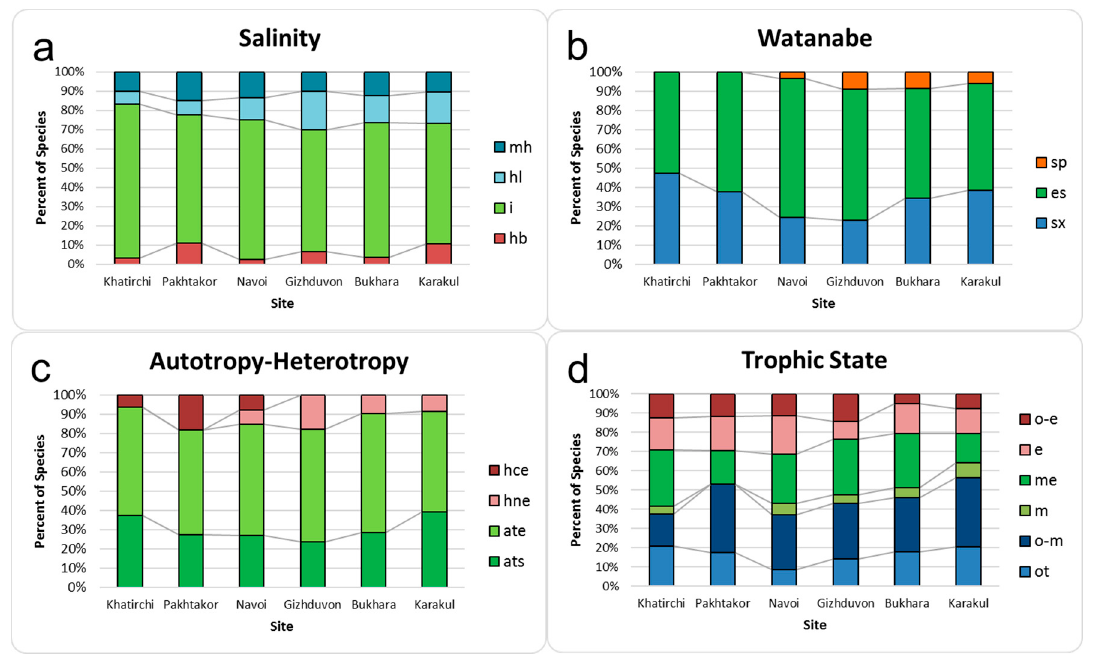
Figure 5. Distribution of bioindicators of salinity preferences, organic pollution according to Watanabe, nutrition type, and trophic state in the Zarafshan River, 2009–2015. Abbreviation for indicator groups: ( a ), Water salinity (Sal): hb, halophobe; i, oligohalobious-indifferent; hl, oligohalobious-halophilous; mh, mesohalobious. ( b ), Organic pollution, Watanabe (D): sx, saproxenes, es, eurysaprobes; sp, saprophiles. ( c ), Nutrition type as Nitrogen uptake metabolism (Aut-Het): ats, nitrogen-autotrophic taxa, tolerating very small concentrations of organically bound nitrogen; ate, nitrogen-autotrophic taxa, tolerating elevated concentrations of organically bound nitrogen; hne, facultatively nitrogen-heterotrophic taxa, needing periodically elevated concentrations of organically bound nitrogen; hce, nitrogen-heterotrophic taxa, needing elevated concentrations of organically bound nitrogen. ( d ), Trophic state (Tro): ot, oligotrafentic; o-m, oligo-mesotraphentic; m, mesotraphentic; me, meso-eutraphentic; e, eutraphentic; o-e, oligo- to eutraphentic.